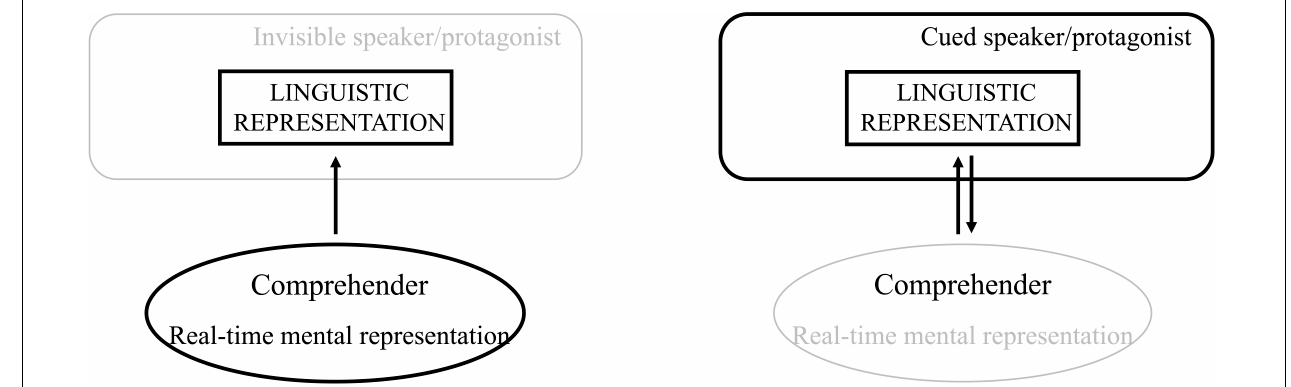
FIGURE 5 | Perspective alignment between the comprehender and the speaker. The left panel illustrates the situation where comprehenders rely on their own world knowledge to build up the real-time mental representation (e.g., objective relations); the right panel illustrates the situation where the speaker/protagonist is made visible by certain linguistic cues (e.g., concessive connectives like although , epistemic stance markers like according to Peter ) and the comprehenders’ ability to accommodate the speaker’s/protagonist’s attitude, argument, etc. when building up the real-time mental